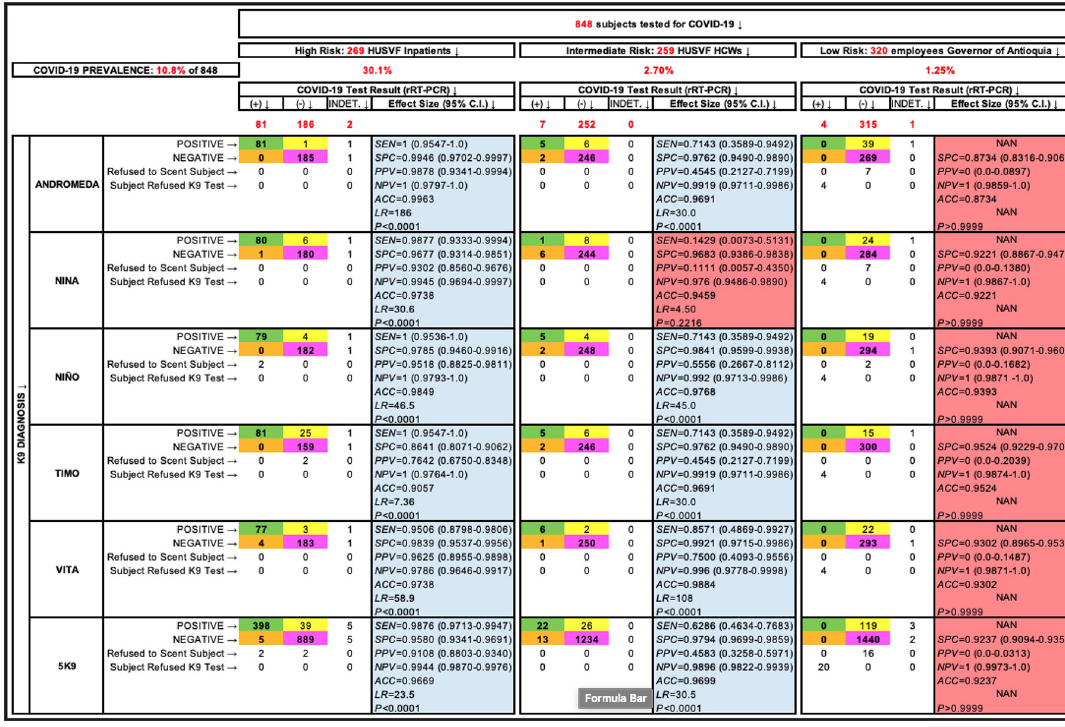
Fig 4. Phase 3: In vivo screening (efficacy trial). Data analysis by risk group of all participants in experiments designed to determine performance metrics of the dogs during in vivo screening. Green, yellow, orange and purple cells contain true positives, false positives, false negatives, and true negatives, respectively. Cells not enhanced contain the number of participants with “indeterminate” rRT-PCR (3), subjects who declined K9 olfaction (4), and those rare occasions where the dogs refused to scent an individual, which happened 7 times with Andromeda and Nina and 2 times with Ni ñ o. Sensitivity could not be computed in the low risk group (NAN: not a number) because all 4 COVID-19 patients declined K9 scent-detection, resulting in 0 in two cells of the 2x2 contingency table and not significant P values in the two-tailed Fisher’s Exact Test (enhanced in salmon